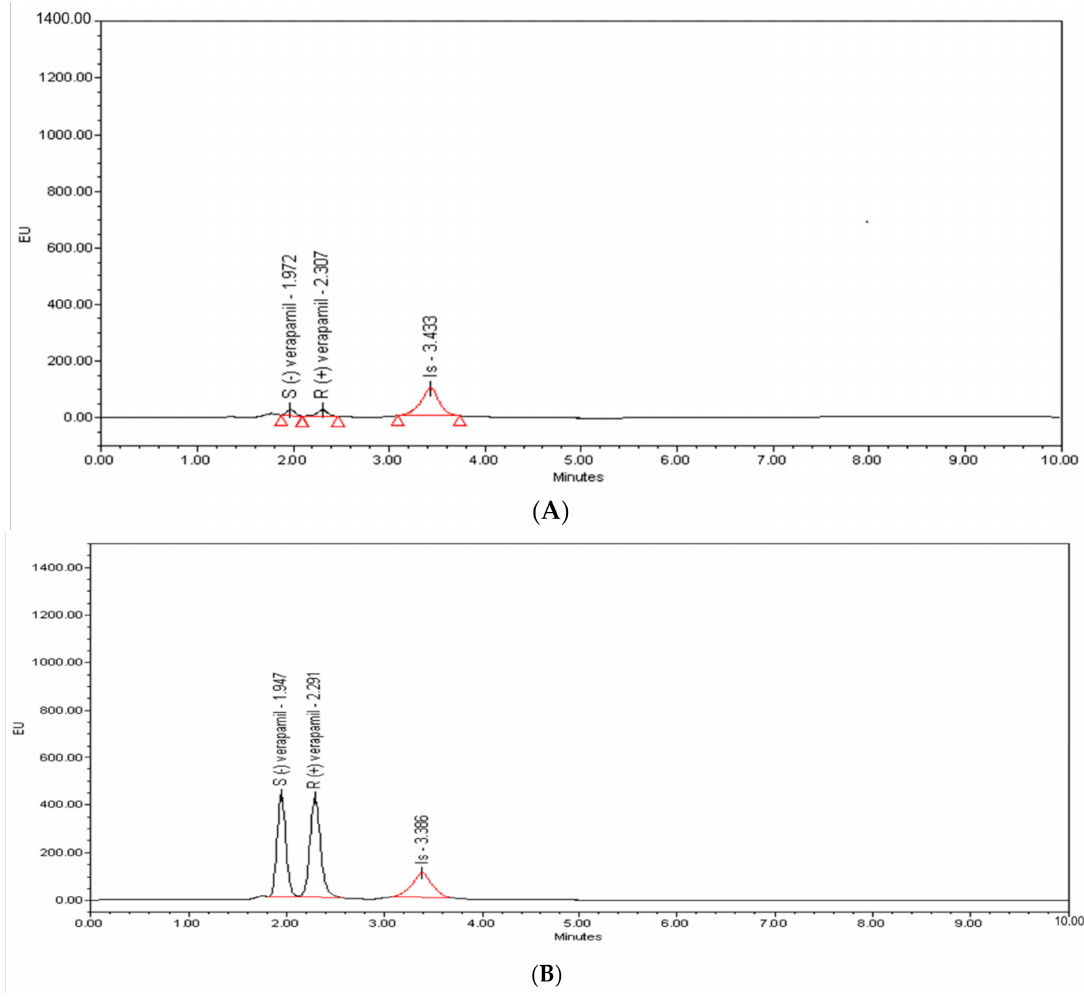
Figure 3. Representative HPLC chromatograms of blank plasma spiked with S-( − )- and R-(+)-verapamil at LLOQ level ( A ) and a plasma sample obtained at 2 h after a single dose of 10 mg/kg racemic verapamil ( B